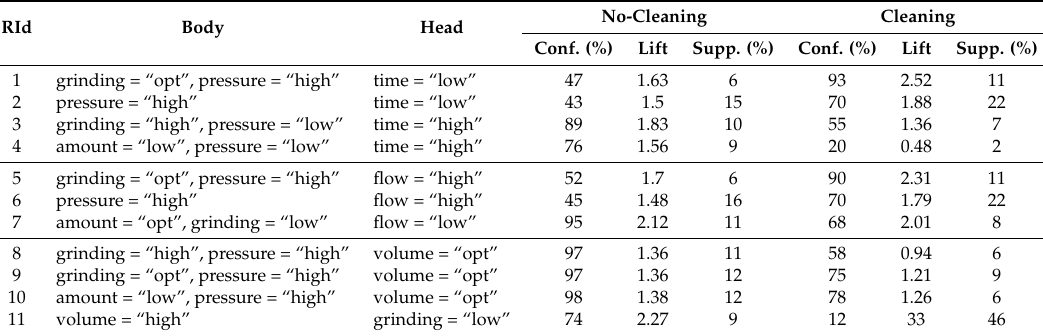
Table 9. Comparison of association rules for presence vs absence of cleaning